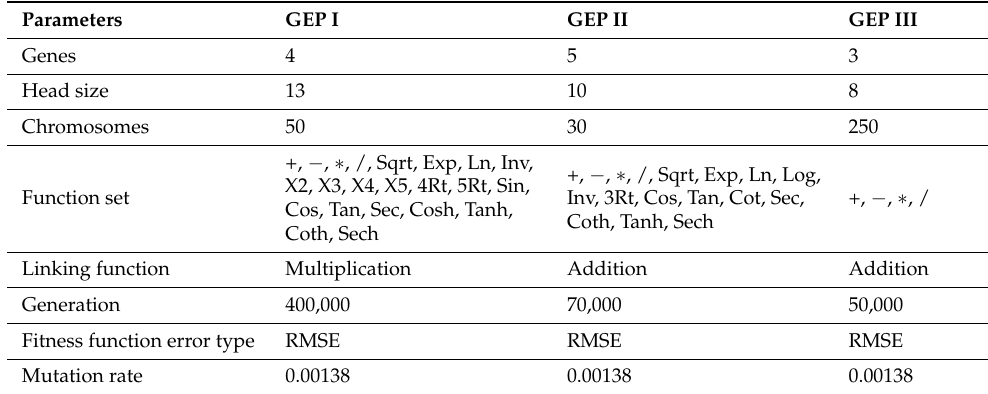
Table 2. Parameters of developed GEP